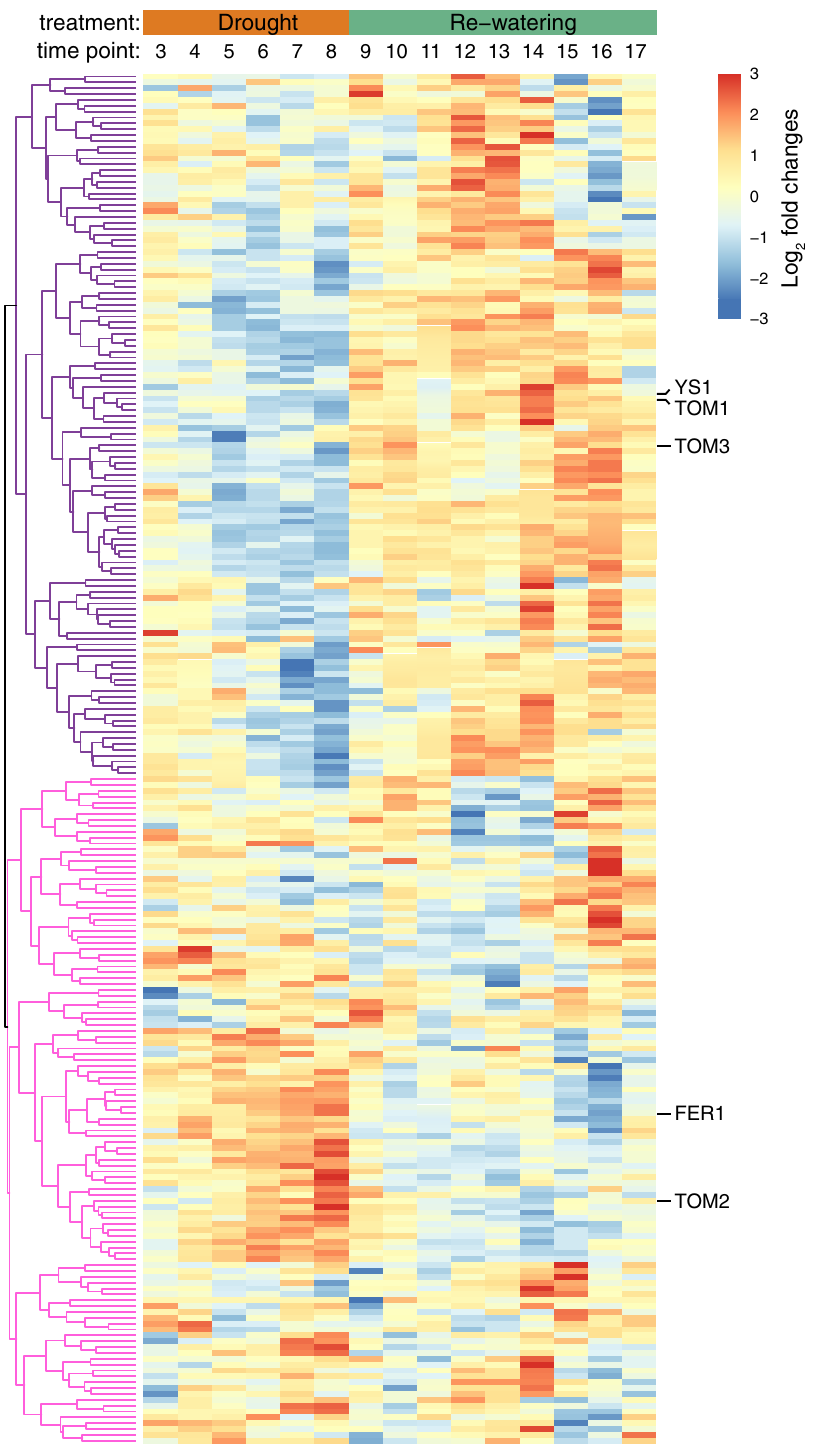
Fig. 5 Iron metabolism gene expression in sorghum roots under drought stress. Log 2 fold expression changes across time ( x -axis) in drought-stressed root tissue for the approximately 234 expressed genes annotated as related to iron homeostasis (see Supplementary Data 3). Time points are indicated across the x -axis at the top, and drought (orange) and recovery (green) treatment stages are indicated above the time points. Hierarchical clustering analysis demonstrates two broad patterns of gene expression: a set of genes exhibiting strong downregulation under drought stress (indicated with purple tree branches), and a set of genes exhibiting strong upregulation under drought stress (indicated with pink tree branches). The fi ve labeled genes on the right represent the genes investigated using qRT-PCR in the maize wild-type and tom1 mutant in the next